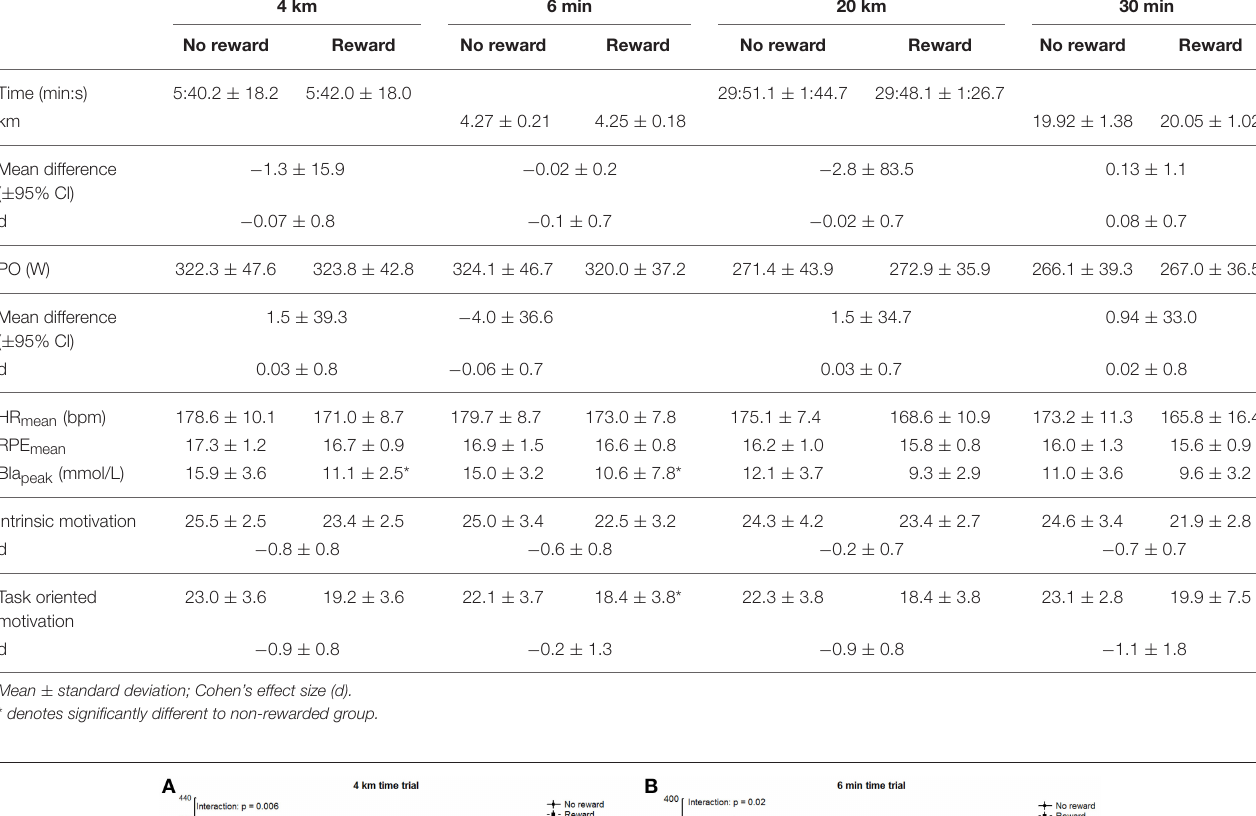
TABLE 2 | Overall results ( n = 23) for both short and long cycling time trials. 4 km 6 min 20 km 30 min No reward Reward No reward Reward No reward Reward No reward Reward